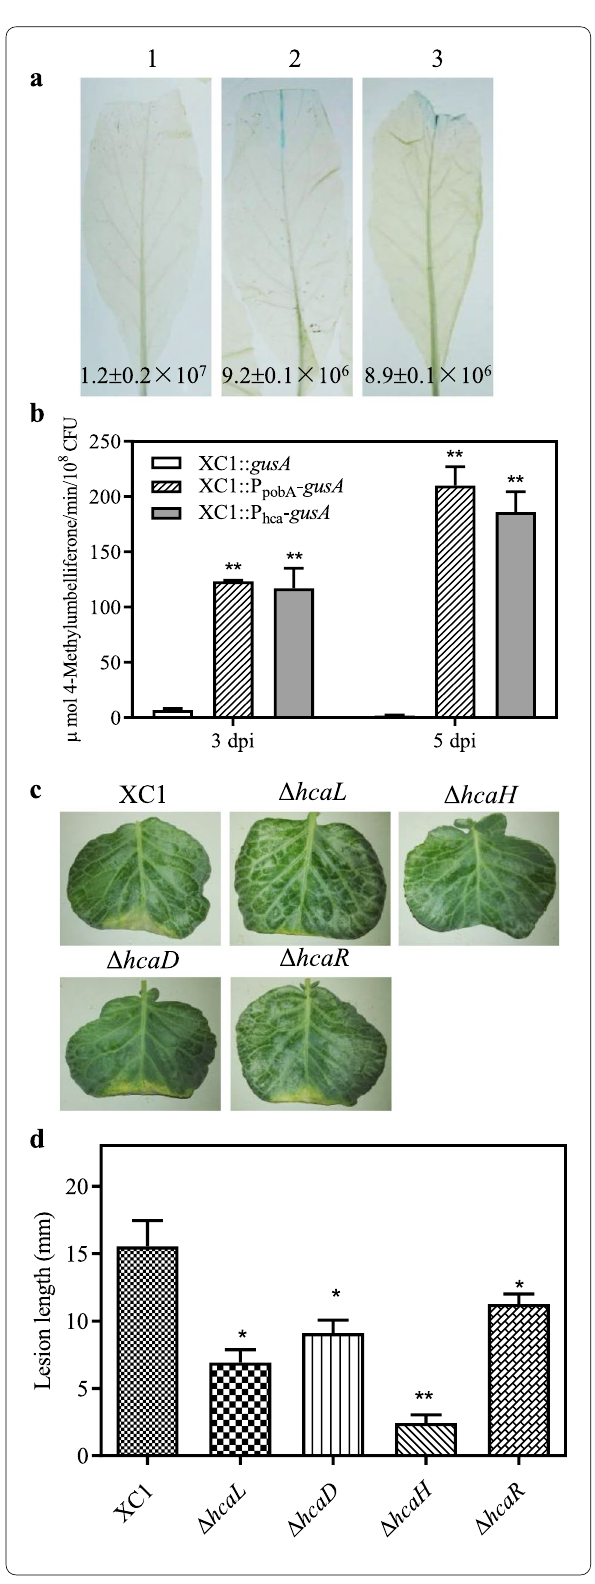
Fig. 7 Expression of the hca promoter in Chinese radish ( Raphanus sativus ) leaves and virulence assays of hca gene deletion strains on cabbage (Jingfeng‑1) leaves. a Xcc colony formation units (CFUs) and GUS histochemical staining in infected Chinese radish leaves. 1, XC1:: gusA; 2, XC1::P pobA -gusA; 3: XC1::P hca ‑ gusA. b Quantitative analysis of different promoter‑driven GUS activities in XC1 strains during infection. c Infection lesions by different mutant strains. d Quantitative analysis of the infection lesions. The virulence of the Xcc strains was tested by measuring lesion length after introducing Xcc into the vascular system of cabbage by leaf clipping. Lesion lengths were measured at 15 dpi. Data shown are averages with standard deviations for 15 plants. Values significantly different from that of strain XC1 are indicated by one ( P < 0.05) or two ( P < 0.01)